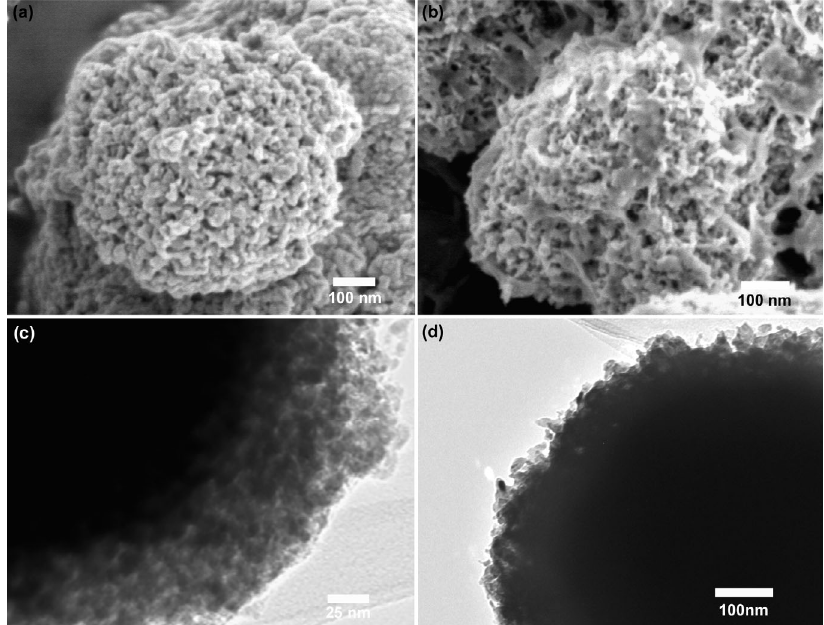
Fig. 4 (a, b) SEM and (c, d) TEM images of the CoSe 2 samples synthesized under the same condition except prolonged hydrothermal reaction time: (a, c) 24 h (Sample E) and (b, d) 48 h (Sample